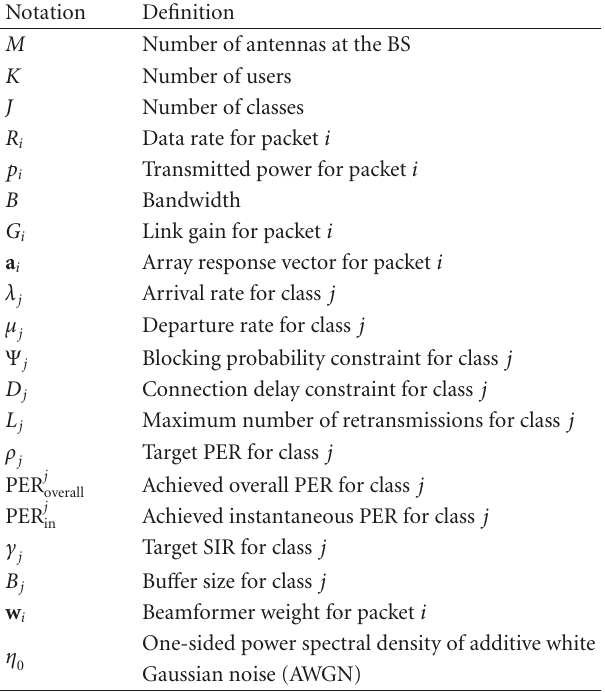
Table 1: Notation and